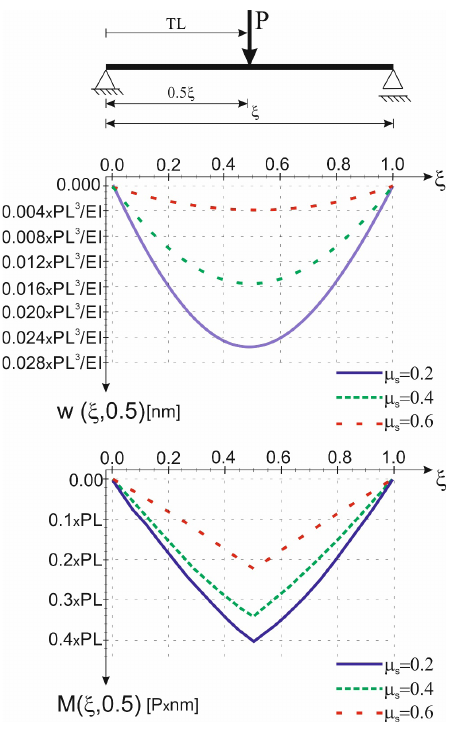
Figure 7: Strain gradient model. Displacement and bending moment of the beam